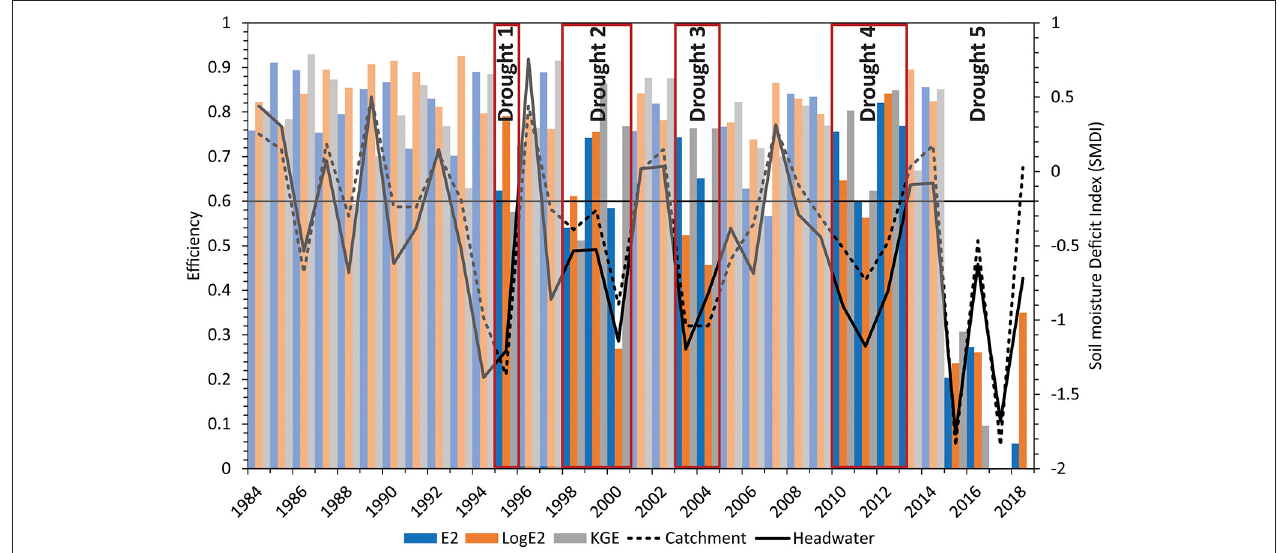
FIGURE 1 | The long-term (1984–2018) efficiency of the JAMS/J2000 model for the Berg River catchment (after Watson et al., 2022), represented as the yearly Nash–Sutcliffe [NSE; Nash, 1970] efficiency in standard form (E2) and logarithmic form (logE2) as well as with the Kling- Gupta efficiency (KGE). The simulated Soil Moisture Deficit Index (SMDI) for the Berg River catchment (black dashed line) and headwater (black line), indicating a reduce performance during “dry” periods when the simulated SMDI was < −